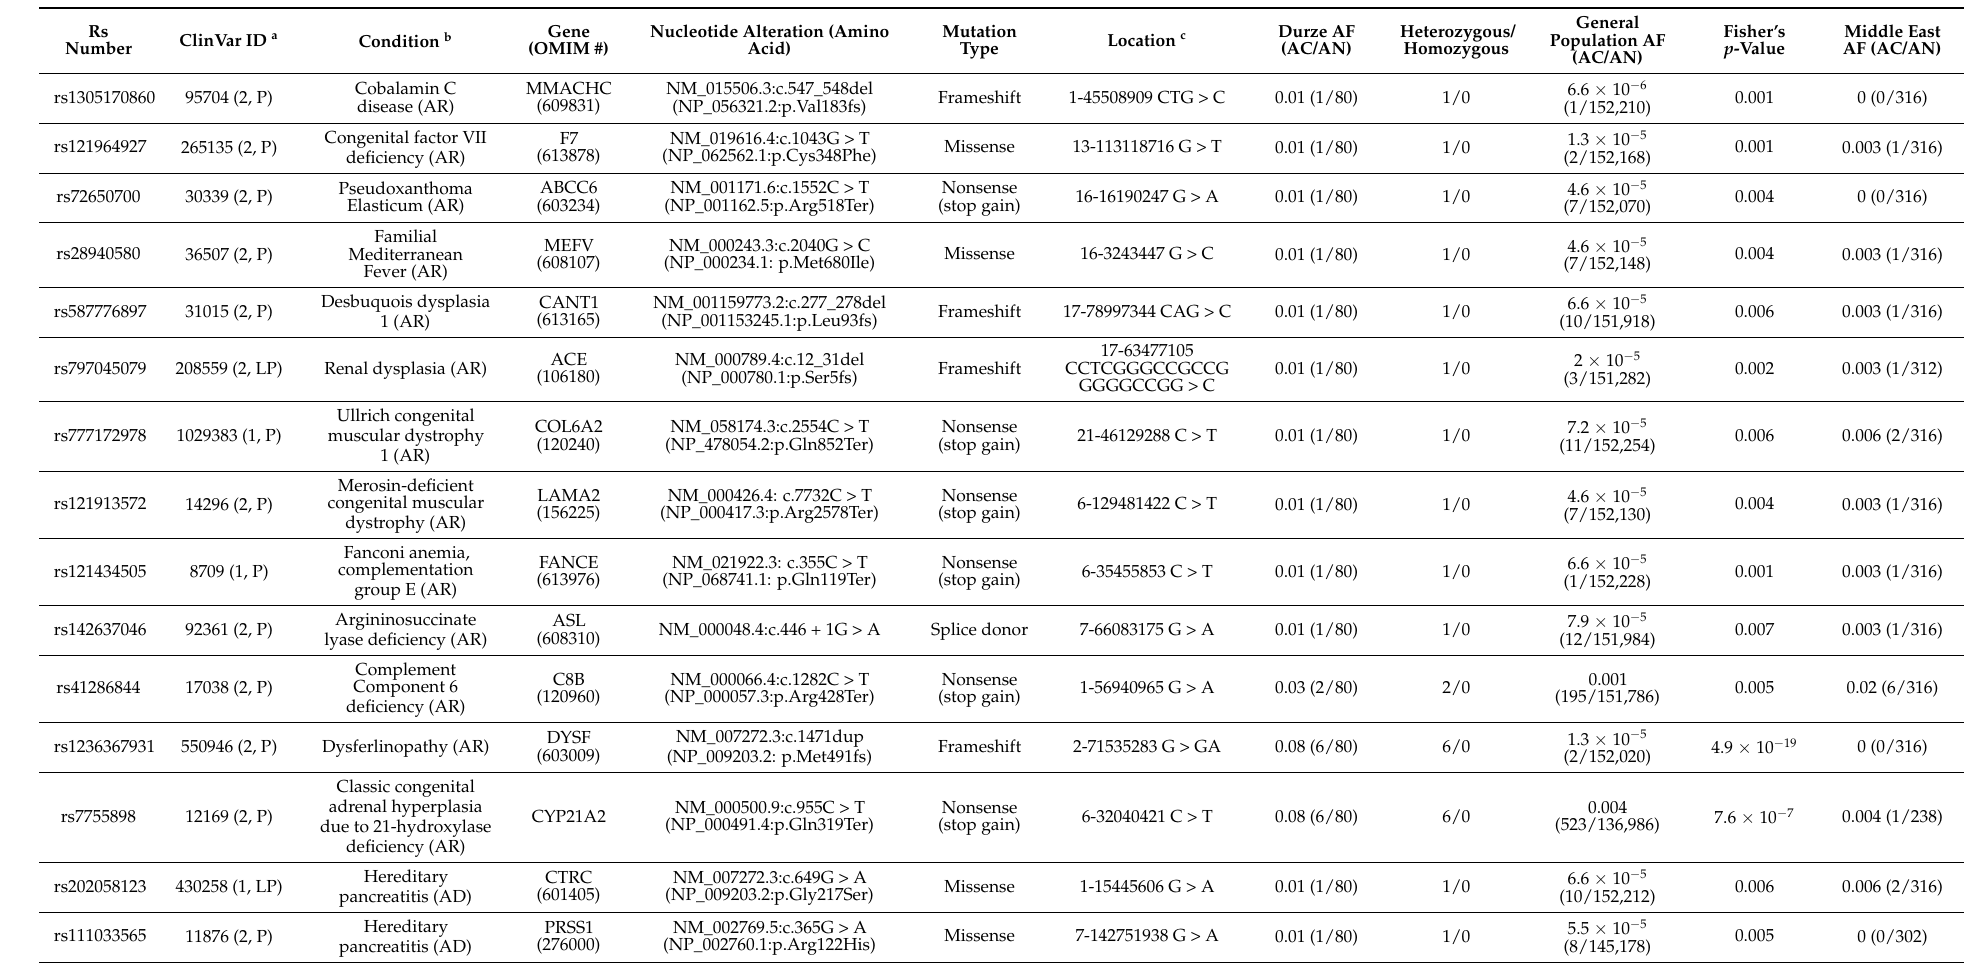
Table 2. Potentially clinically relevant genes and variants from HGDP genome sequencing